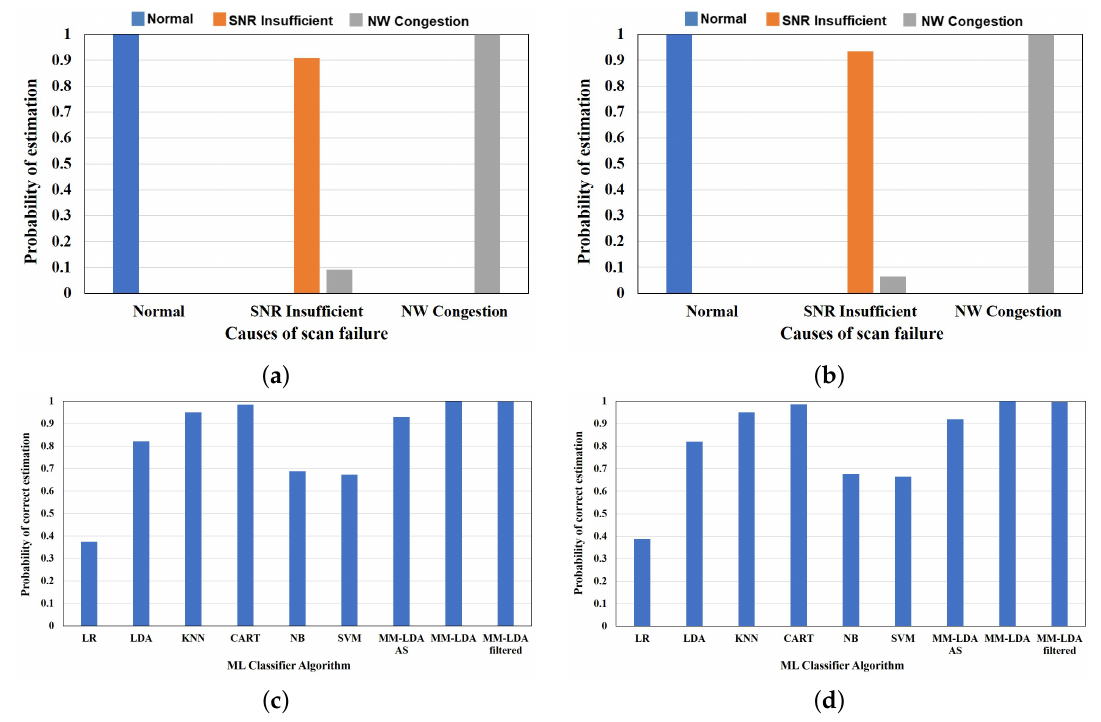
Figure 10. Scan failure/delay cause estimation of training and testing samples. ( a ) Training samples— proposed MM-LDA; ( b ) test samples—proposed MM-LDA; ( c ) training samples—comparison to other conventional methods; ( d ) test samples—comparison to other conventional methods.